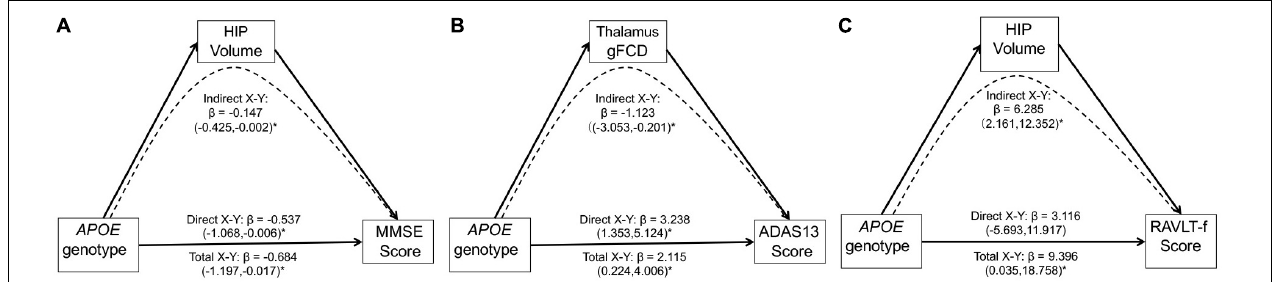
FIGURE 5 | Mediation analyses show that the hippocampal volume and gFCD of the thalamus mediate the relationship between the APOE genotypes and cognitive performance in the MCI group. The asterisks mean the direct/indirect effect is significant. (A) The hippocampal volume negatively mediates the influence of APOE genotypes on the MMSE score in the MCI group. (B) gFCD values in the right thalamus negatively mediates the influence of APOE genotype on the ADAS score in the MCI group. (C) The hippocampal volume positively mediates the influence of APOE genotype on the RAVLT-forgetting score in the MCI group. gFCD, global functional connectivity density; MCI, mild cognitive impairment; HIP, hippocampus; MMSE, Mini-Mental State Examination; ADAS, Alzheimer’s disease assessment scale; RAVLT, Rey Auditory Verbal Learning